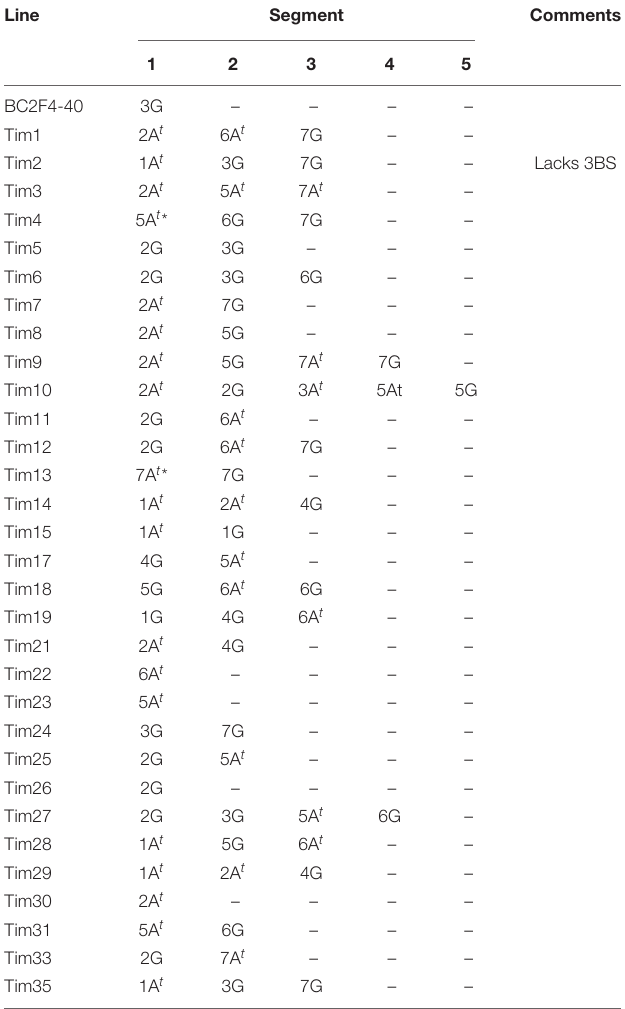
TABLE 2 | Chromosomal segments of T. timopheevii in Paragon wheat introgression lines.